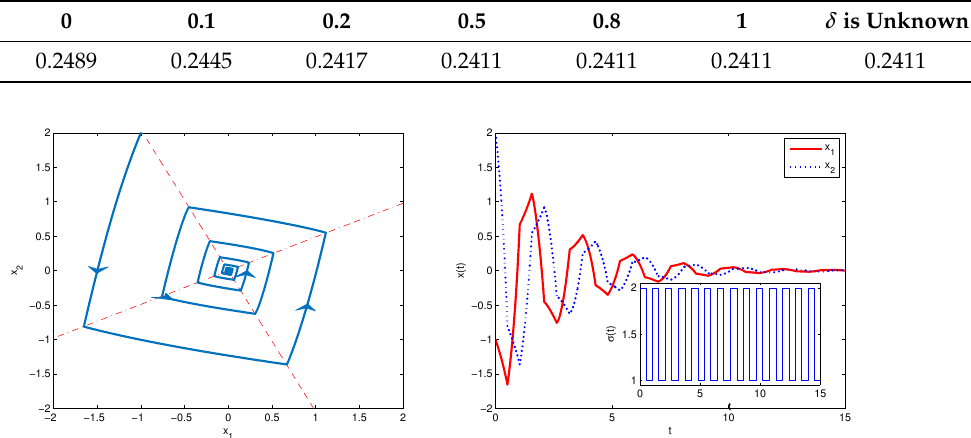
Figure 1. The stable dynamics ( Left ) and convergent response curves ( Right ) of the system in Example 1 with d ( t ) = 0.1 + 0.1sin ( 10 t )